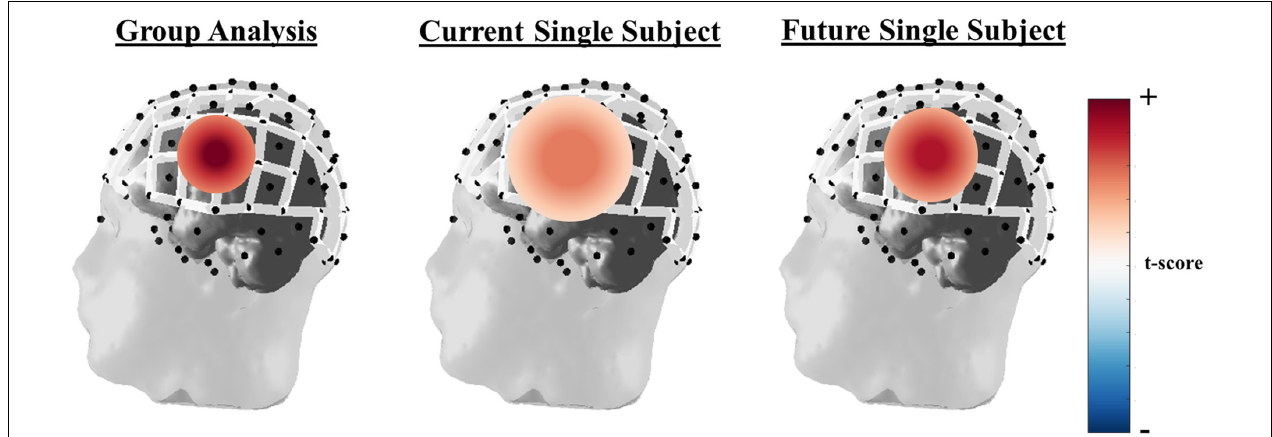
FIGURE 4 | Idealized GLM output for a right-hand finger tapping task at the group (left) , current single subject fNIRS analysis capabilities (middle) , and where single subject fNIRS analysis needs to be in order to be clinically relevant (right) . The example of oxyhemoglobin is used in this depiction.